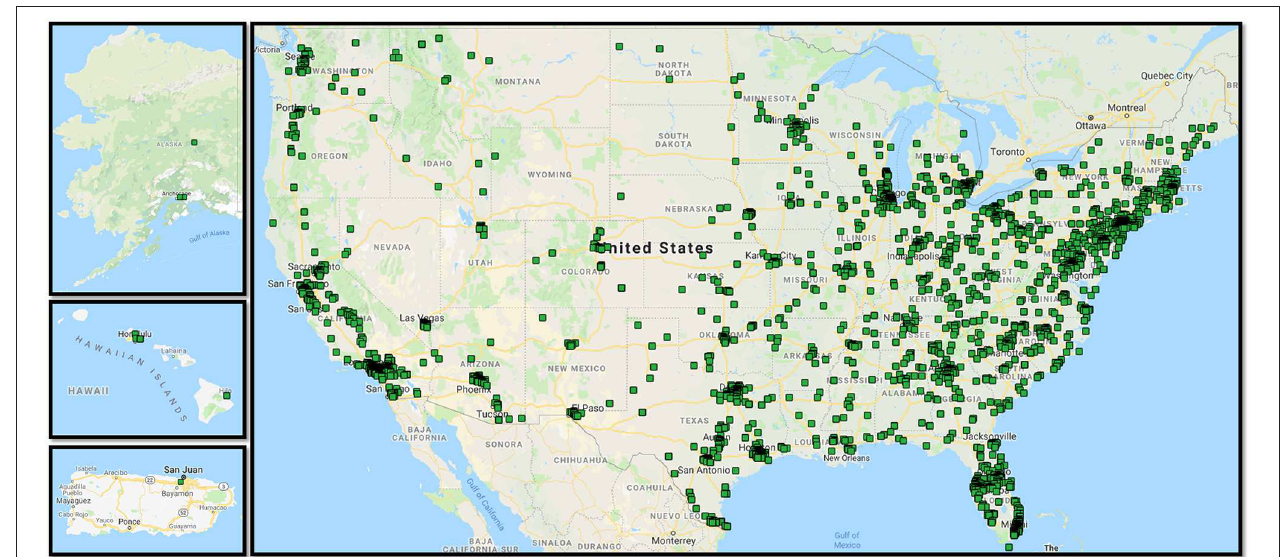
FIGURE 1 | Mapped survey responses for the National cohort study. Map made using BatchGeo